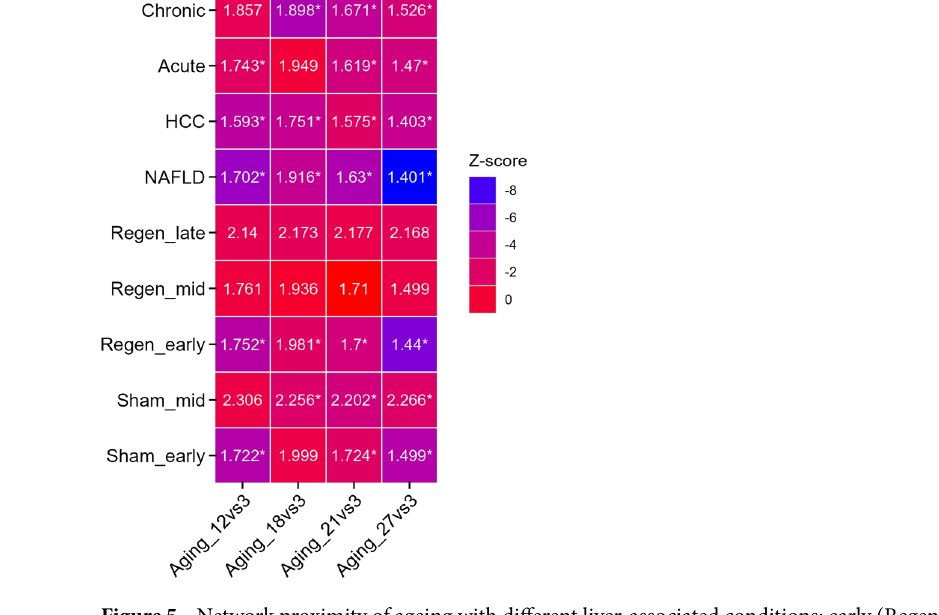
Figure 5. Network proximity of ageing with different liver-associated conditions: early (Regen_early), mid (Regen_mid) and late (Regen_late) phases of liver regeneration, early and mid-phases of sham-operated control, NAFLD, HCC, Acute and chronic liver damages. The proximity is explored for different age groups (12, 18, 21 and 27 months). Text in the tiles represents proximity distance. *Indicates FDR < 0.05 and Z-score < −